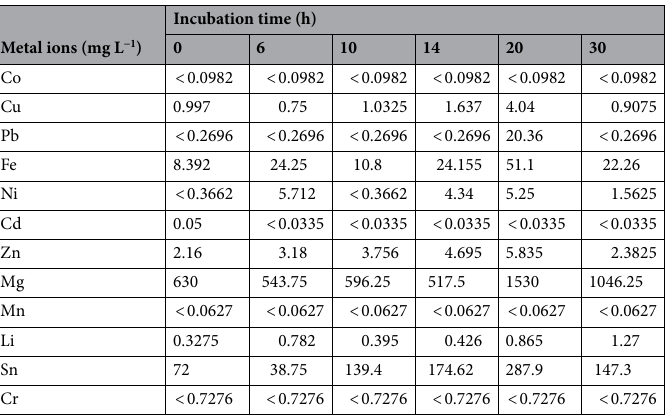
Table 6. Flame AAS for heavy metal analysis of shake-flask batch